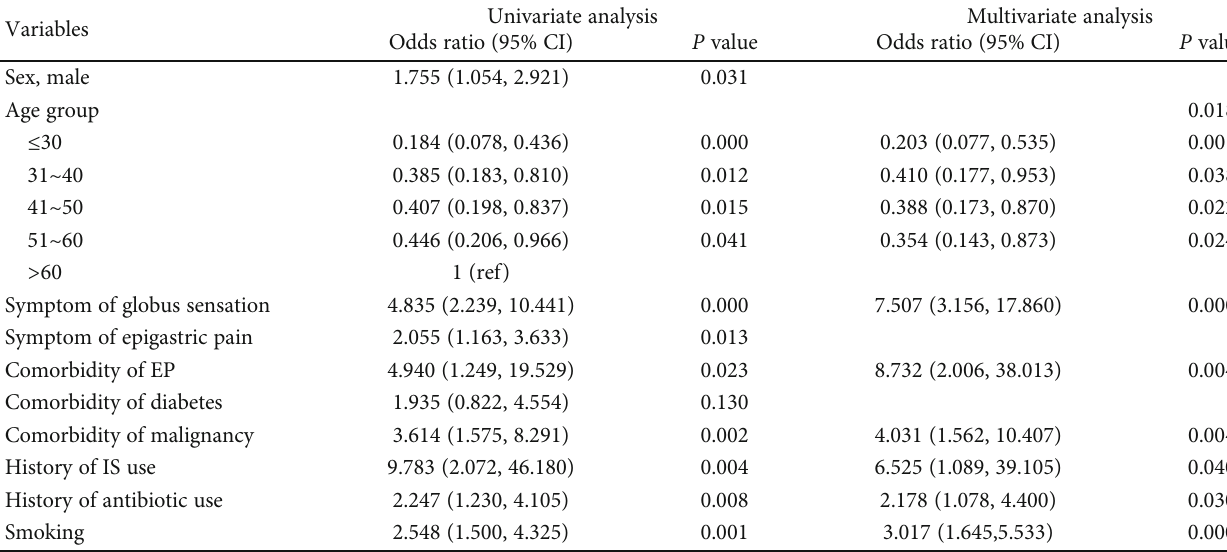
Table 3: Univariate and multivariate regression analyses of the factors related to